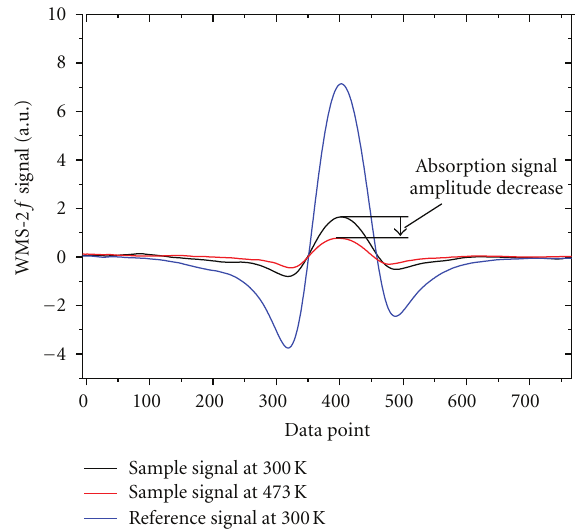
F 2: Example of WMS- 2f signals showing the signal magni- tude and shape change induced by temperature